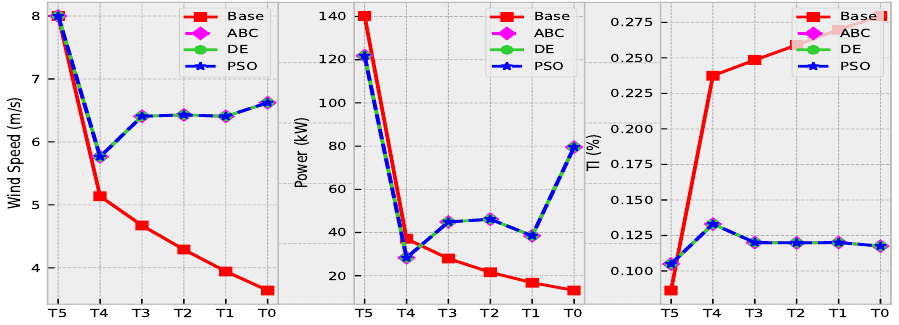
Figure 12. 4 D deployment distance at 8 m/s mean wind speed.